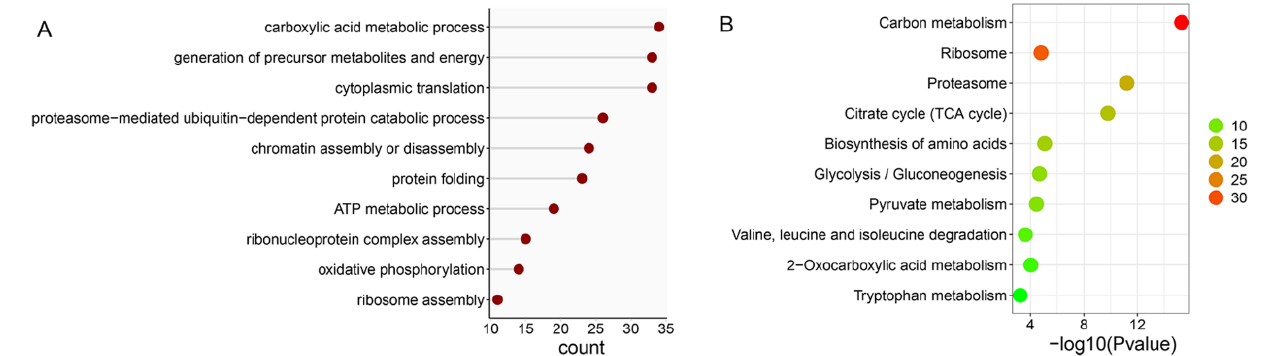
Figure 4. Analysis of downregulated ubiquitinated proteins in the testis of D. melanogaster due to Wolbachia infection. ( A ) Gene ontology enrichment analysis based on biological process. ( B ) KOBAS pathway analysis. The color indicates the difference in protein counts. The redder the color, the more the count; the greener the color, the less the count.